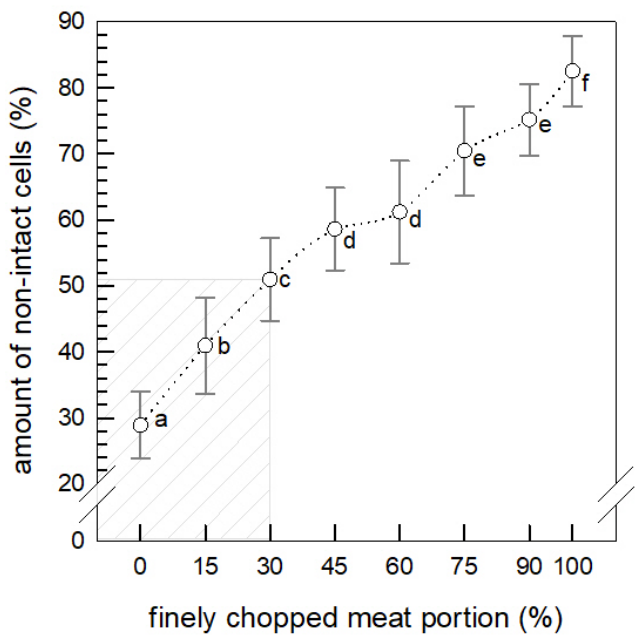
Figure 2. Amount of non-intact cells ( n = 16) (mean ± standard deviation) of raw minced meat with finely chopped meat (FCM) added. The shaded area shows the realistic range of the FCM addition. Different letters indicate significant differences ( p < 0.05).